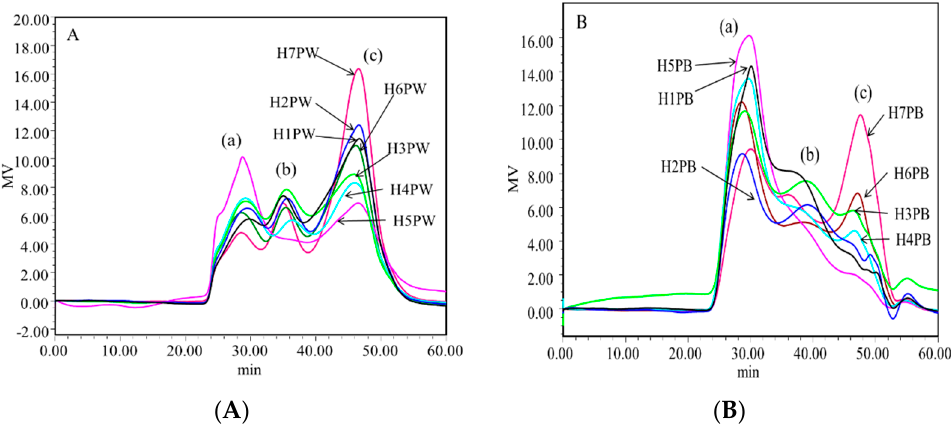
Figure 4. HPLC spectrogram of ( A ) water-soluble and ( B ) alkaline-soluble cell wall polysaccharide fractions from Hericium erinaceus fruiting bodies at different growth stages. Table 1. Molecular weight distribution of water-soluble and alkaline-soluble cell wall polysaccharides from H. erinaceus fruiting bodies at different growth